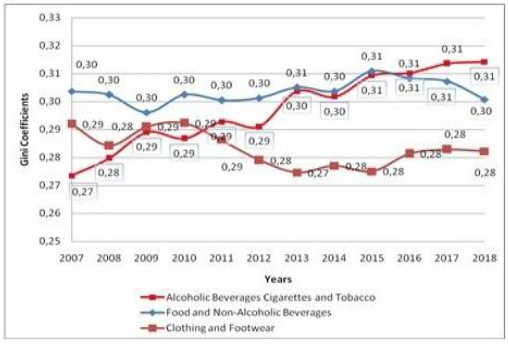
Figure 2. The Course of the Gini Coefficients of the Inequalities of Expenditure Rates at the NUTS-2 Regional Level between 2007 and 2018 Source: Composed by